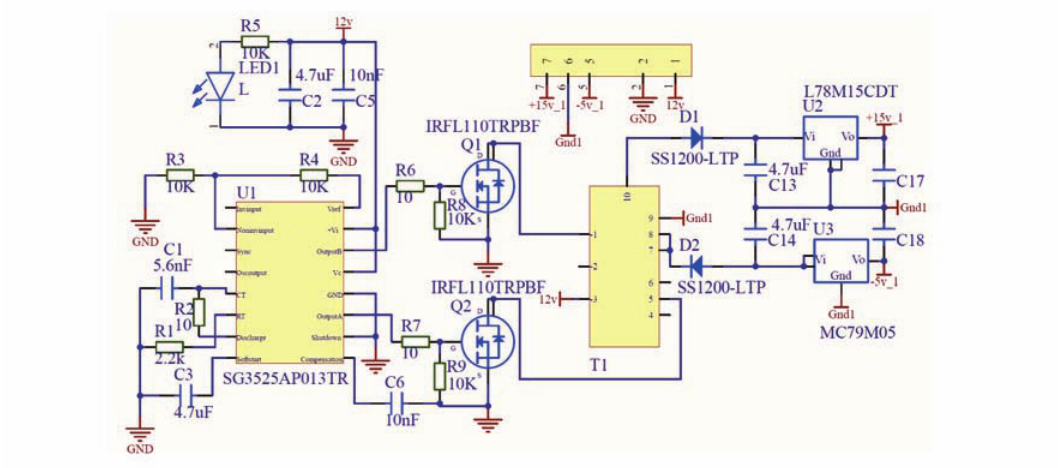
g. 16. Circuit diagram of the gate drive circuit generated by electronic design automation software. Fi